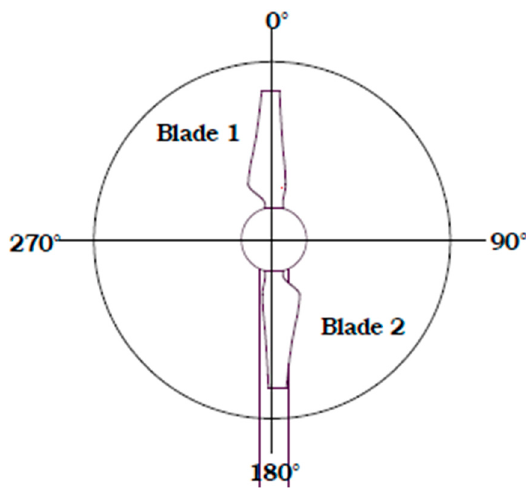
Figure 7. Rotor angular positions for the presentation of results.